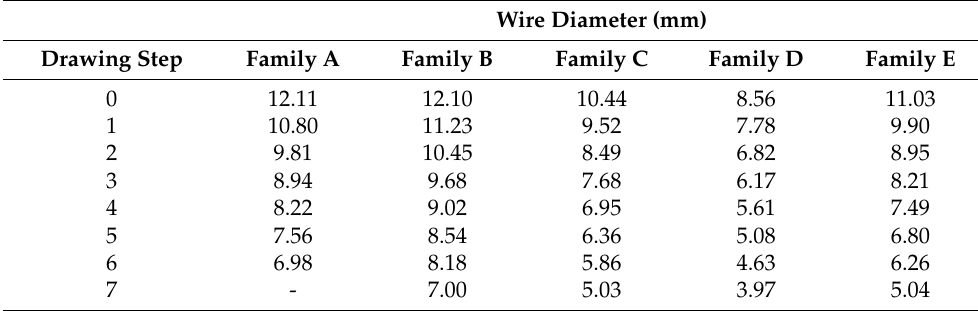
Wire Diameter (mm)